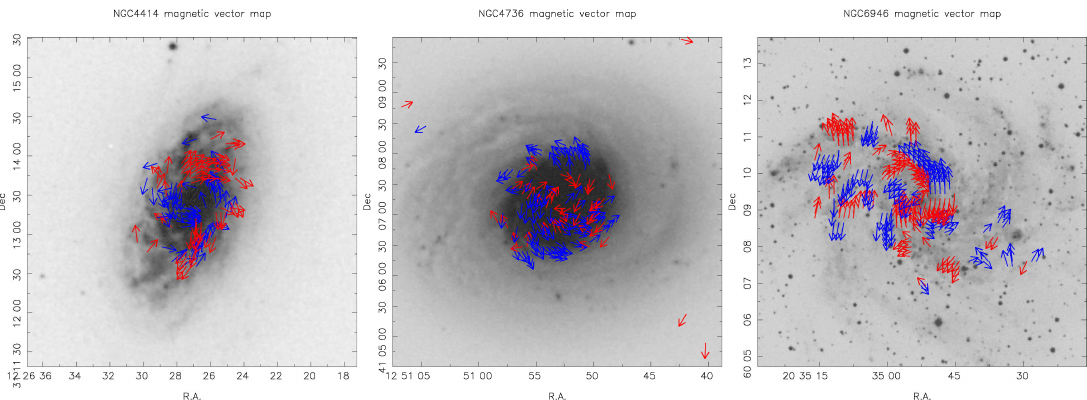
Figure 4. Magnetic-field-vector maps of NGC4414 ( left ), NGC4736 ( middle ), and NGC6946 ( right ) obtained by applying our new method. Background gray-scale images were taken from DSS. Red and blue vectors denote clockwise and counterclockwise vectors, respectively.